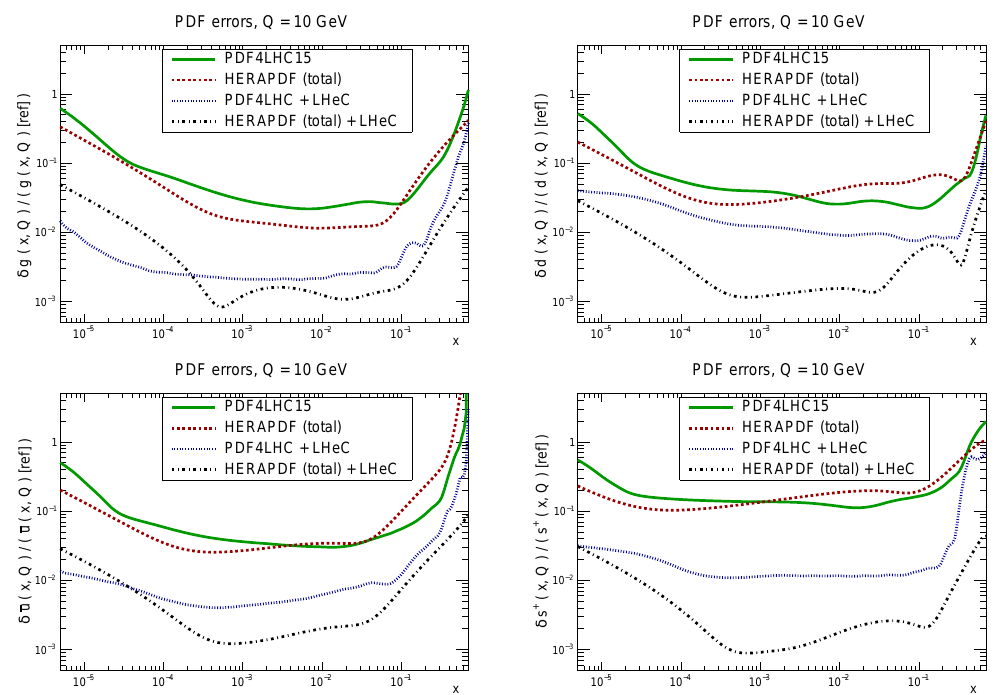
Figure 5.3: Same as Fig. 5.1, where now the baseline HERAPDF2.0 includes not only the experimental PDF uncertainty, but also the corresponding model and parametrization